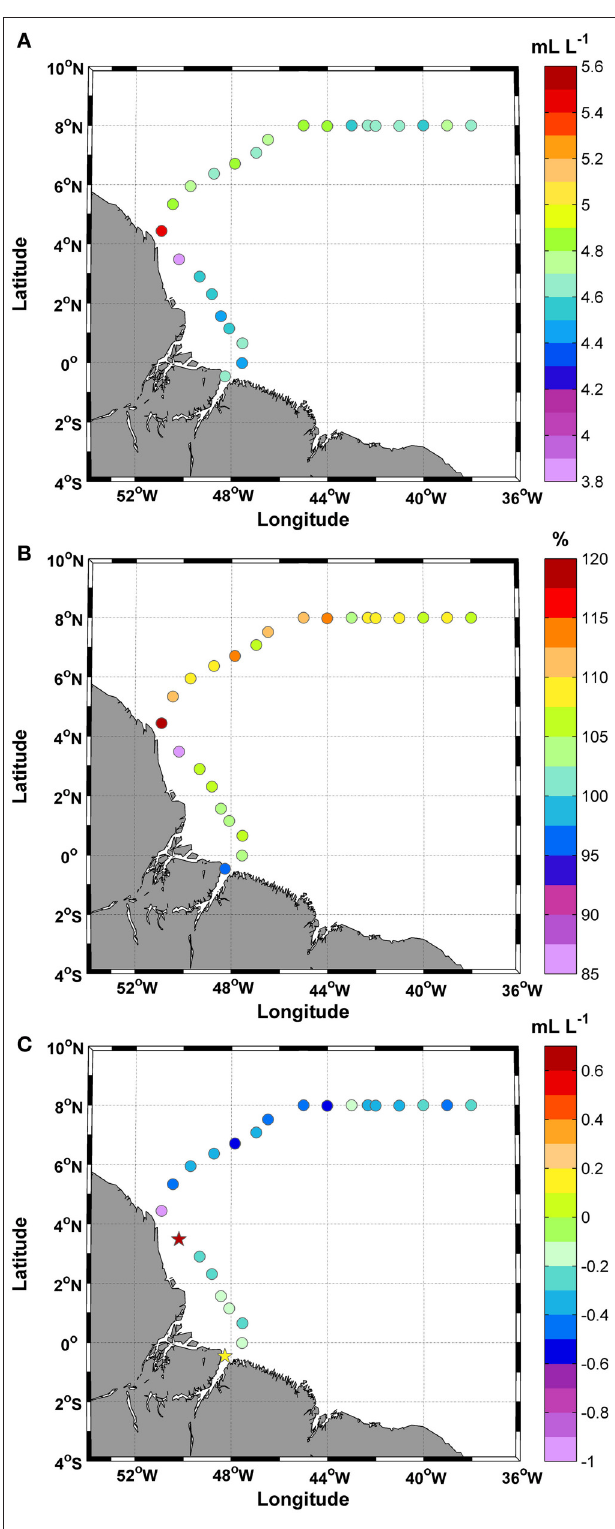
FIGURE 4 | Distributions of (A) Dissolved oxygen (DO); (B) Saturation of DO (%); and (C) Apparent oxygen utilization (AOU) along the ship track during the CF3 cruise, October